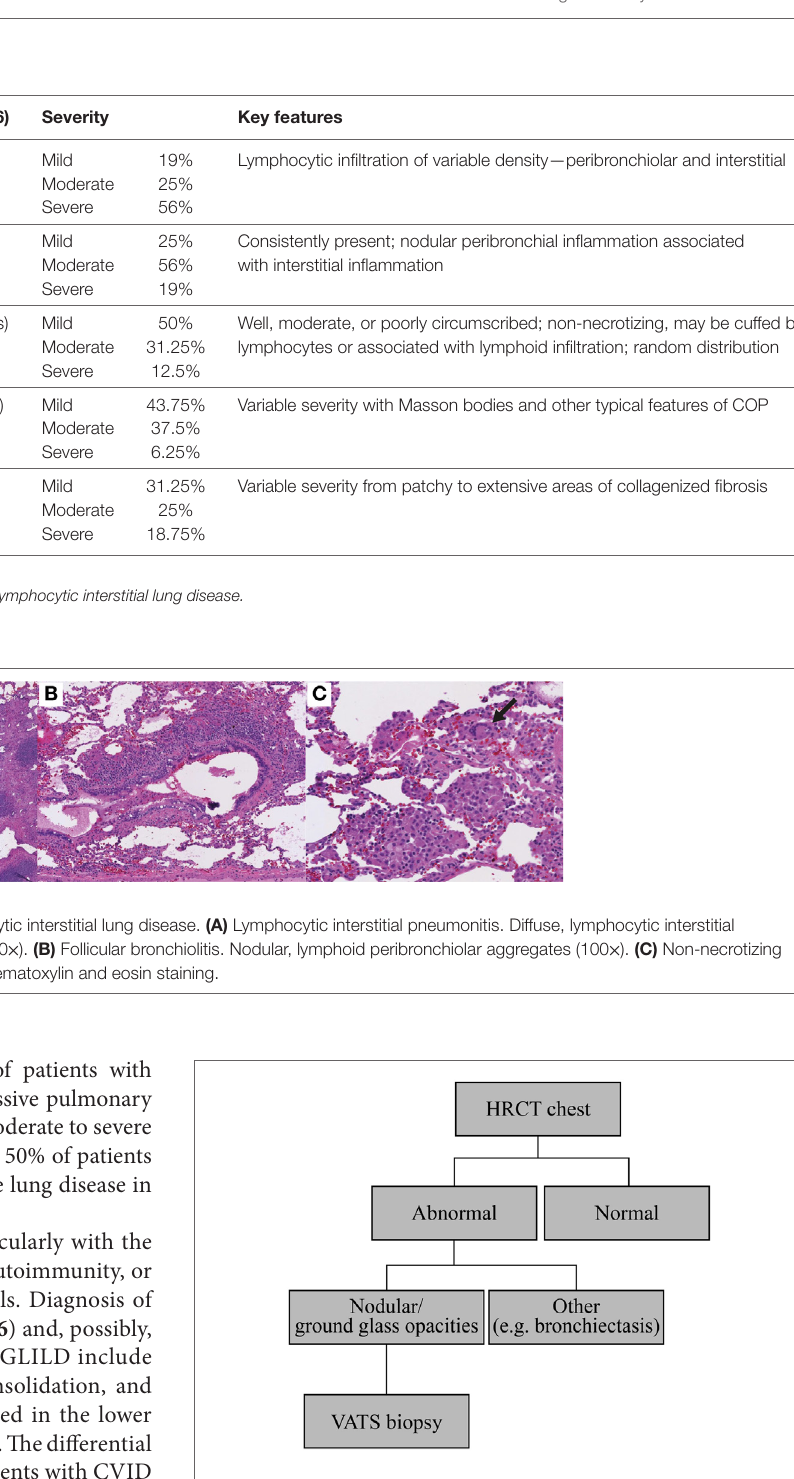
FigURe 6 | Granulomatous-lymphocytic interstitial lung disease diagnostic algorithm. All patients with common variable immunodeficiency should have a high-resolution computed tomography (HRCT) of the chest to screen for pulmonary disease. If there is significant interstitial lung disease (ground glass abnormalities, nodules, and areas of consolidation), one should consider lung biopsy by video-assisted thoracoscopic surgery (VATS) for definitive diagnosis. It may be worth considering if a more easily accessible organ such as a lymph node could be useful for detection of granulomas.